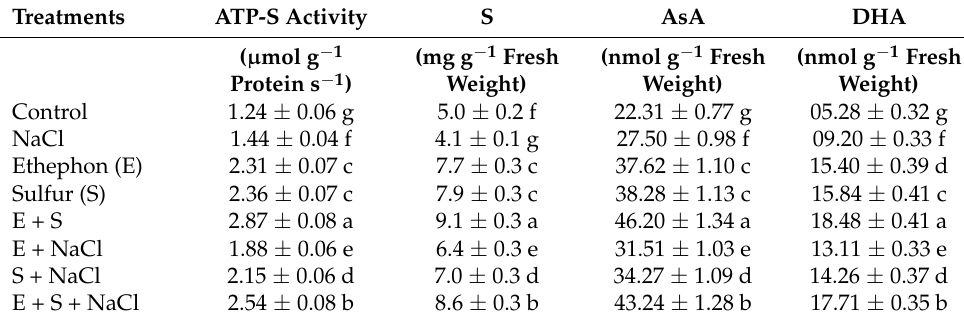
Table 3. Activity of ATP-sulfurylase (ATP-S), and content of sulfur (S), ascorbate (AsA), and dehy- droascorbate (DHA) in mustard leaves at 30 days after sowing. Plants were treated with 200 µ L L − 1 ethephon and/or 200 mg S kg − 1 soil (S) in presence or absence of 100 mM NaCl. Data are presented as means ± SE ( n = 4). Data followed by same letter are not significantly different by LSD test at p <